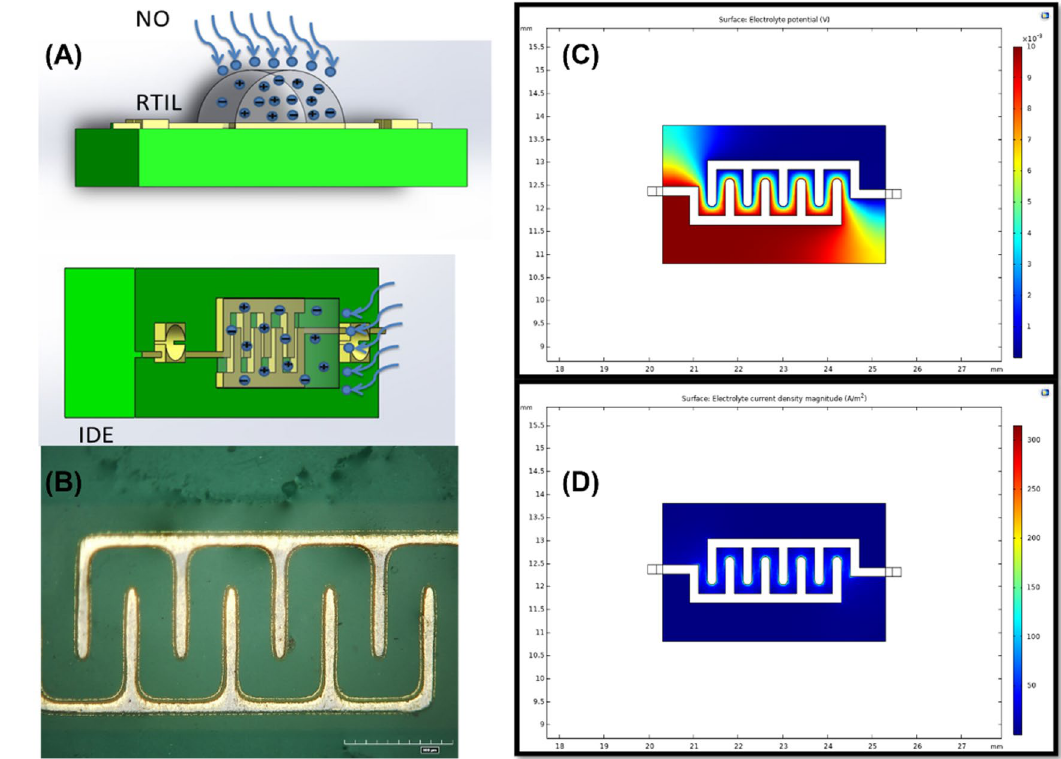
Figure 1. ( A ) Schematic of the IDE modified with RTIL and NO sensing (using Microsoft PowerPoint). ( B ) Microscopy image of the modified electrode (HIROX microscope). ( C ) COMSOL simulation (https:// www. comsol. com/) representing electrolyte potential for working and reference electrodes. ( D ) COMSOL simulation (https:// www. comsol. com/) representing electrolyte current density for working and reference